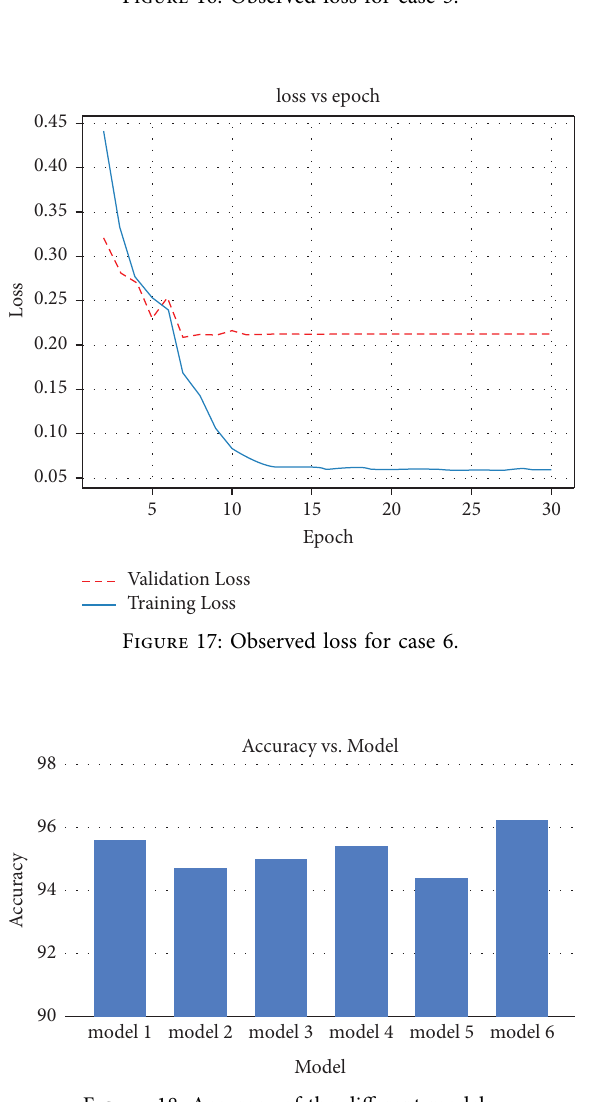
Figure 16: Observed loss for case 5.